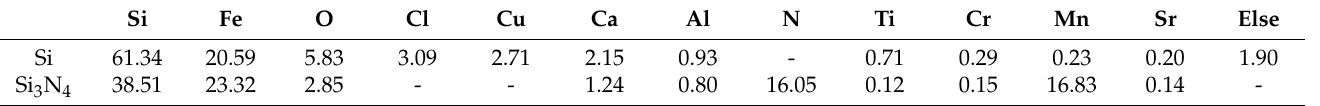
Table 1. The chemical compositions of Si and Si 3 N 4 powders